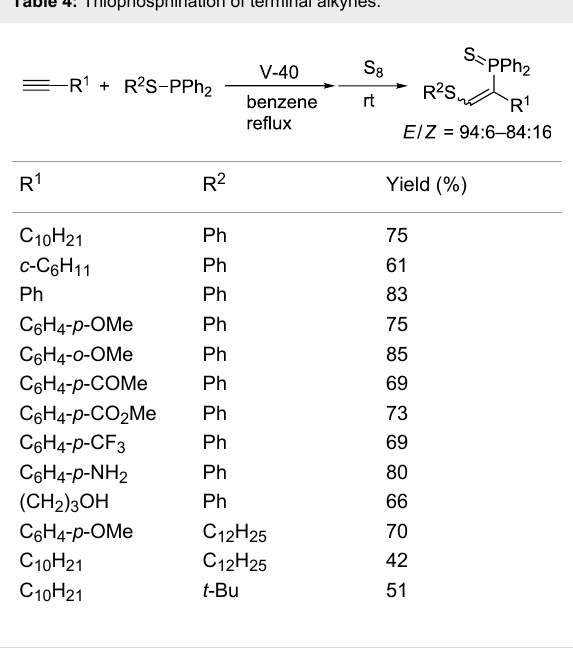
Table 4: Thiophosphination of terminal alkynes.